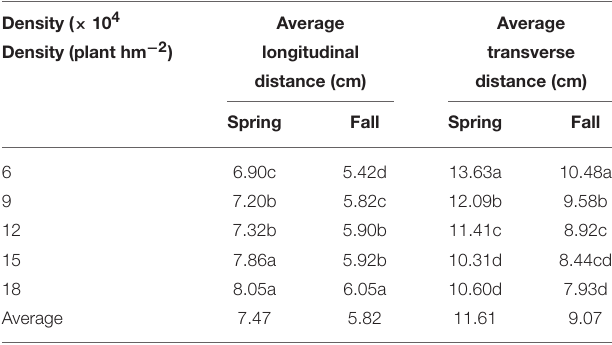
TABLE 5 | Average longitudinal and transverse distance under different densities in the two growing